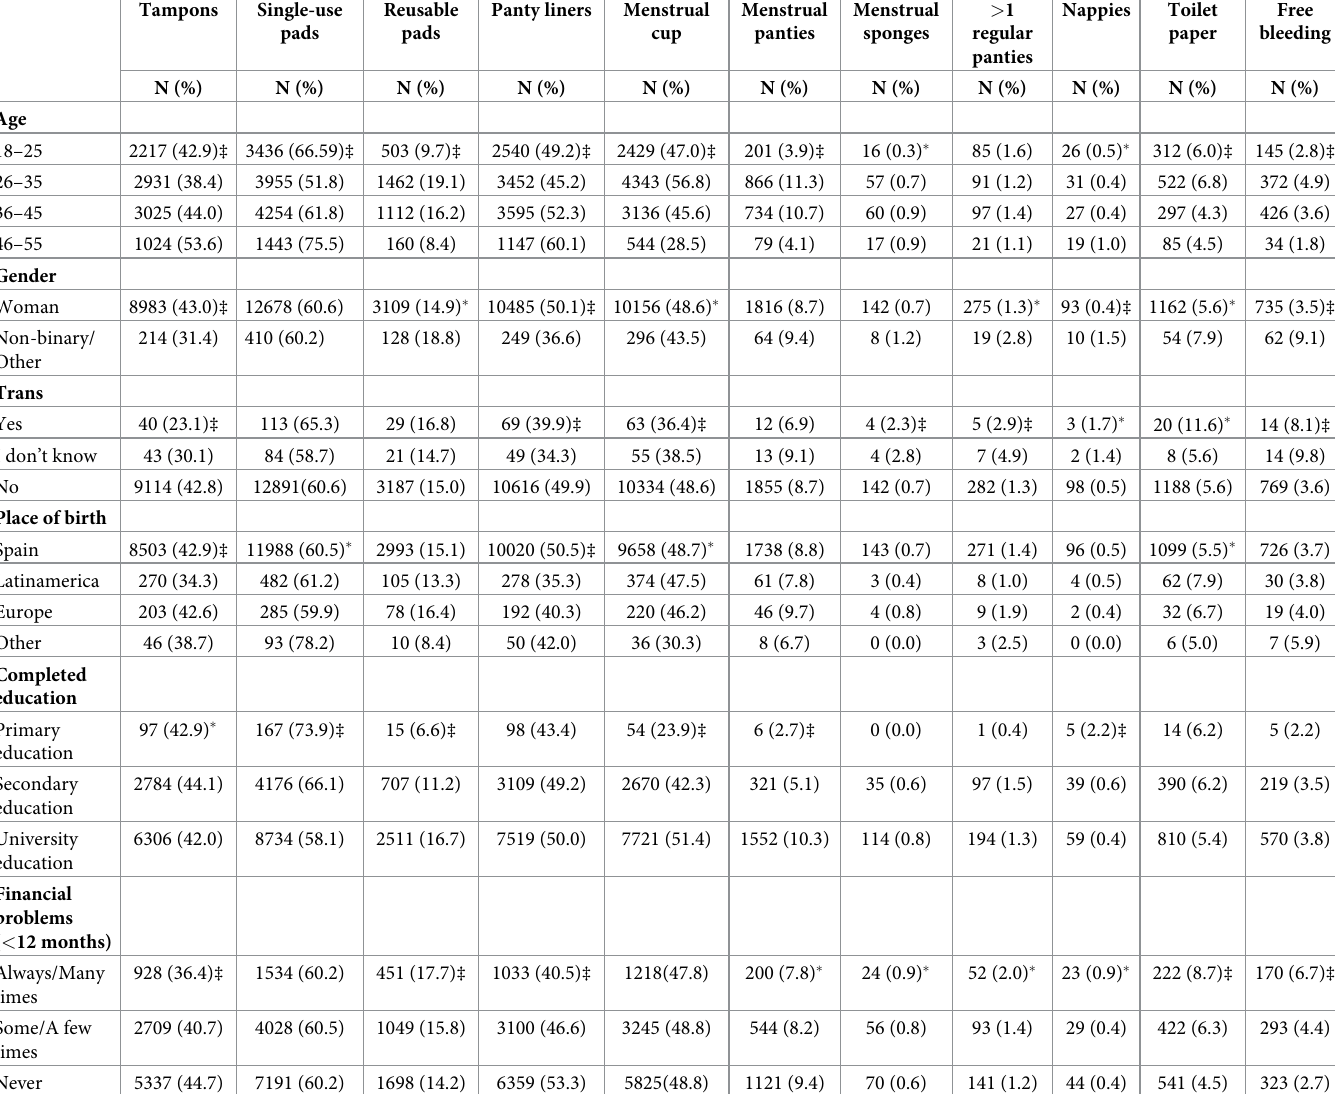
Table 4. Use of menstrual products by age, gender identity, trans identification, country of birth, completed education and financial constraints (last 12 months) (N =